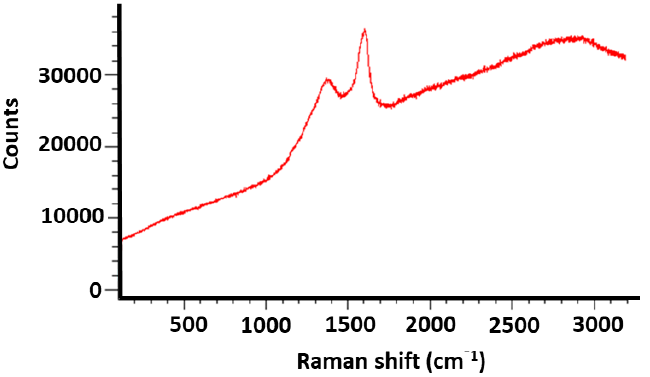
Figure 7. Raman spectrum of